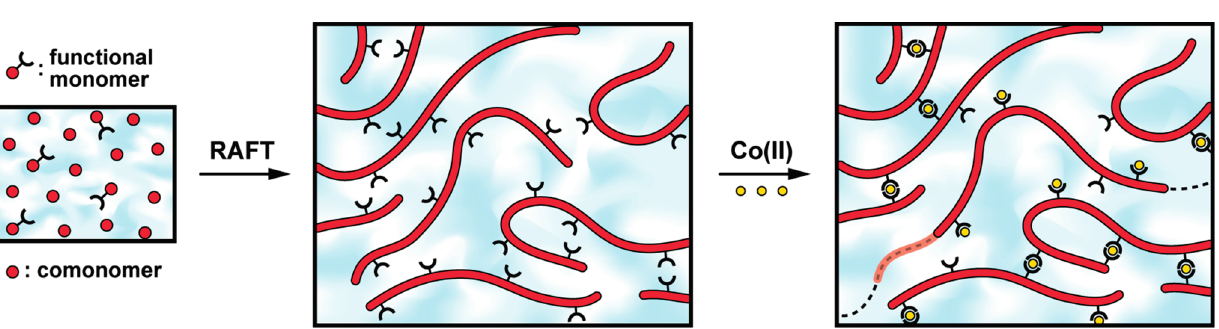
Figure 1. Schematic representation for the synthesis of a side-chain ligand-functionalized copolymer and its assembly into a metallo-supramolecular